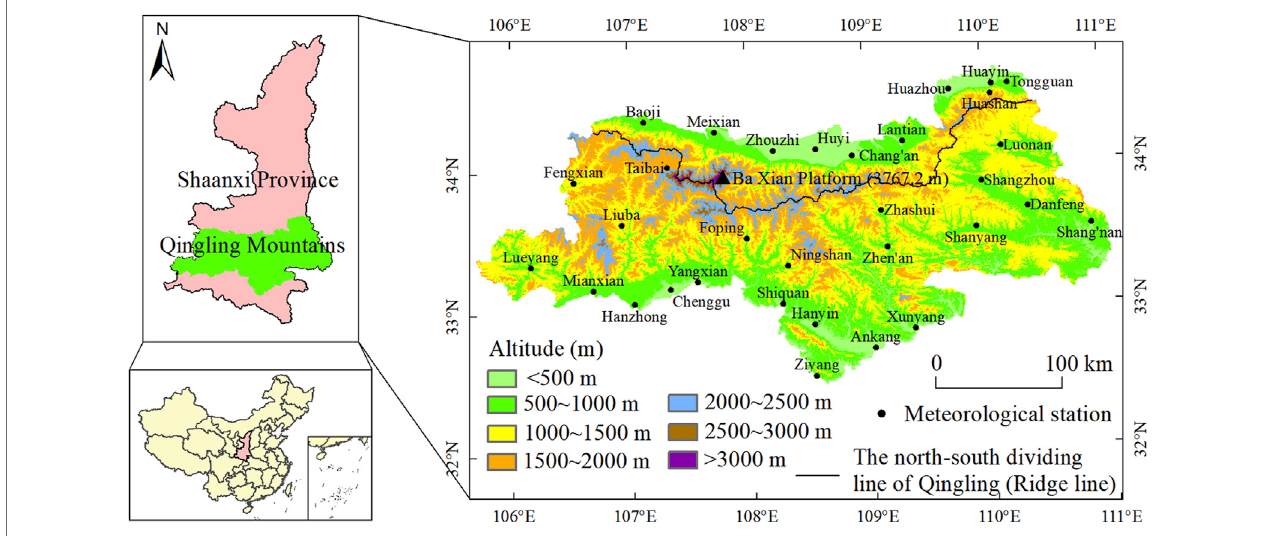
FIGURE 1 | Geographical environment and distribution of meteorological stations in the southern and northern slopes of the Qinling Mountains.